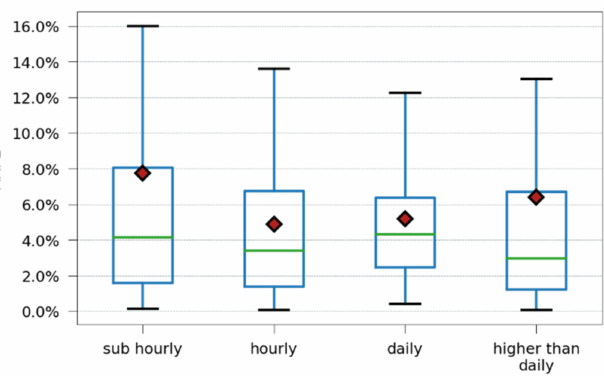
Figure A1. Boxplot of MAPE values by different temporal resolutions. The same mode of display as in Figure 10. This shows that temporal resolution (length of time steps) does not seem to necessarily have an impact on accuracy measured by MAPE.